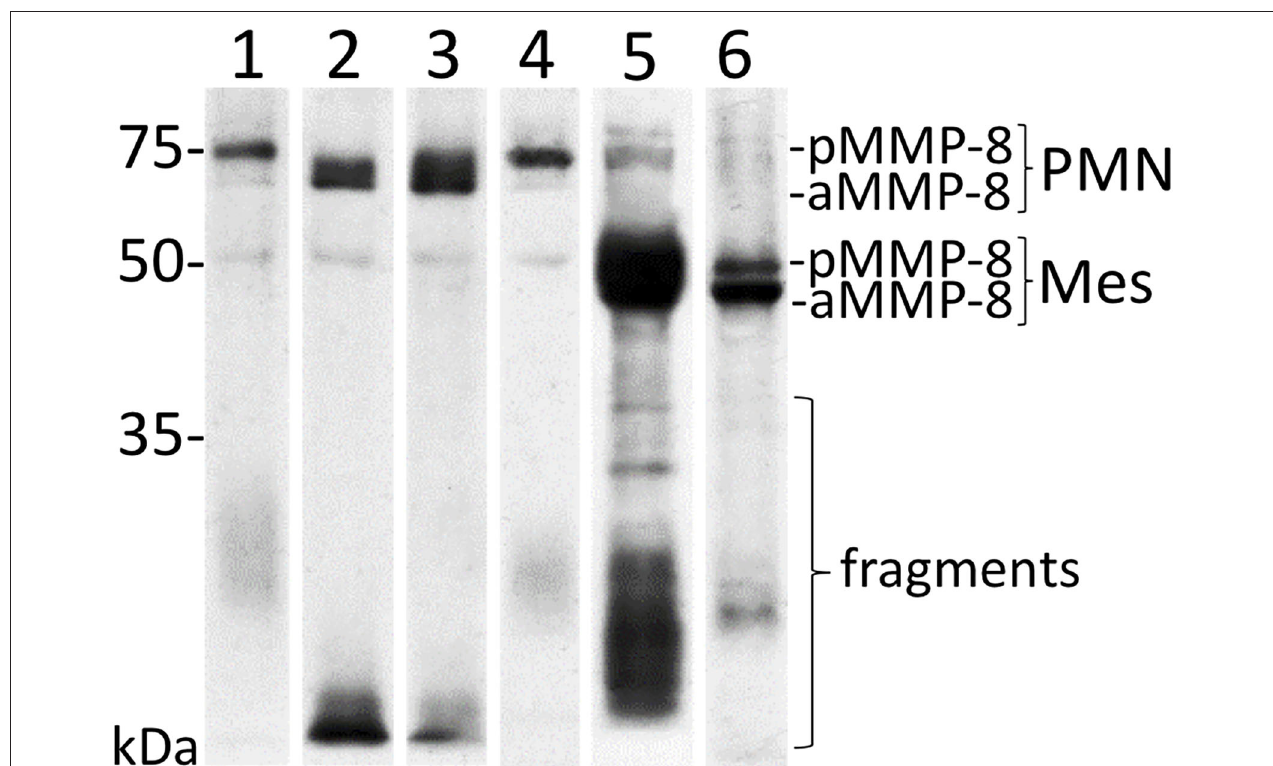
FIGURE 1 | Representative Western immunoblot for molecular forms and species of MMP-8/collagenase-2 in human mouthrinse samples. Lane 1: recombinant human MMP-8, polyclonal antibody; lane 2: recombinant human MMP-8 activated by 200 µ M NaOCl, polyclonal antibody; lane 3: periodontitis mouthrinse before treatment with polyclonal anti-MMP-8; lane 4: periodontitis mouthrinse after treatment with polyclonal anti-MMP-8; lane 5: periodontitis mouthrinse before treatment with monoclonal anti-MMP-8; lane 6: periodontitis mouthrinse after treatment with monoclonal anti-MMP-8. The p- and aMMP-8 (PMN and Mes) indicate neutrophil pro (p) and active (a) (PMN)- and fibroblast-type (Mes), MMP-8, respectively, and fragments indicate lower ( < 50 kDa) size MMP-8 species. Molecular weight markers are indicated on the left